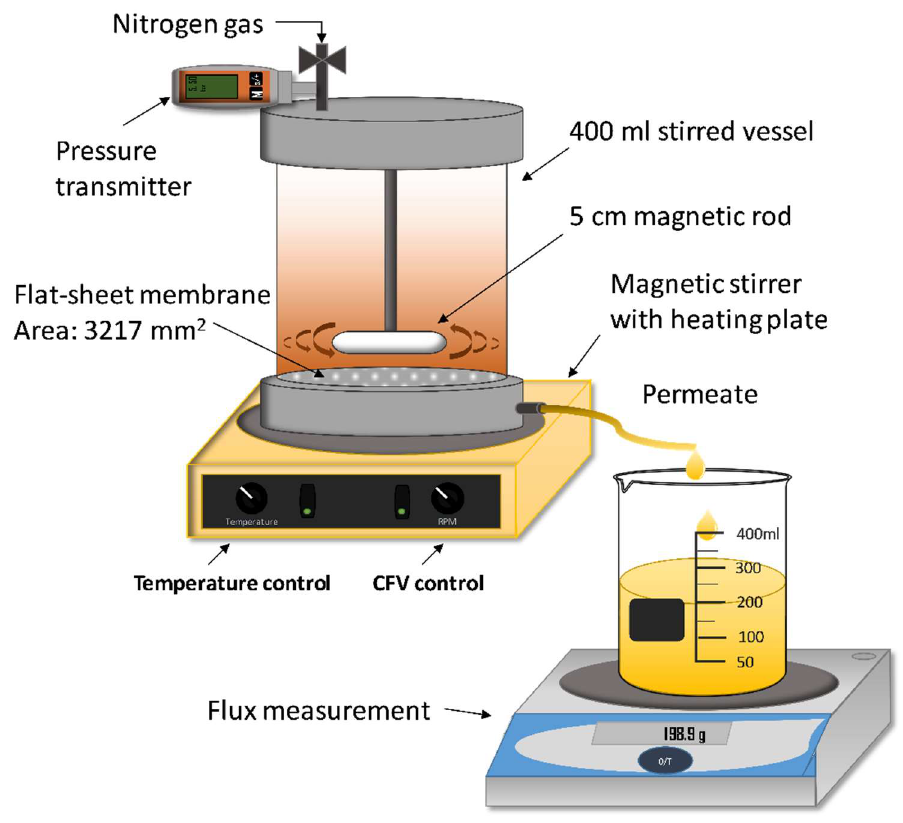
Figure 1. Illustration of the setup used for the membrane filtration. CFV = cross-flow velocity